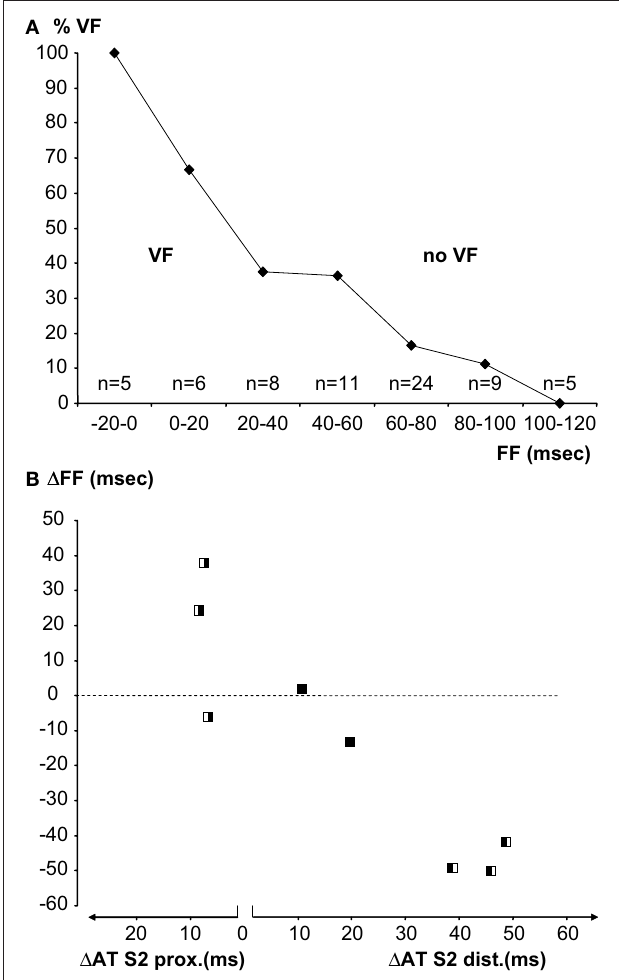
Figure 6 | (A) Percentage of successful inductions of VF in bins of 20 ms FF. With increasing FF the induction success decreases. Numbers represent all induction attempts in eight experiments. (B) Individual paired observations (see Materials and Methods) of the relation between the S2-activation delay induced by flecainide and the FF. The symbols indicate the inducibility of VF before and after application of flecainide (white VF, black no VF, left before, right after flecainie). The left panel represents increase in activation delay in the proximal (pinacidil) domain, the right panel activation delay in the distal (sotalol) domain. Slowing of activation in the proximal domain is antiarrhythmic, slowing in the distal domain is